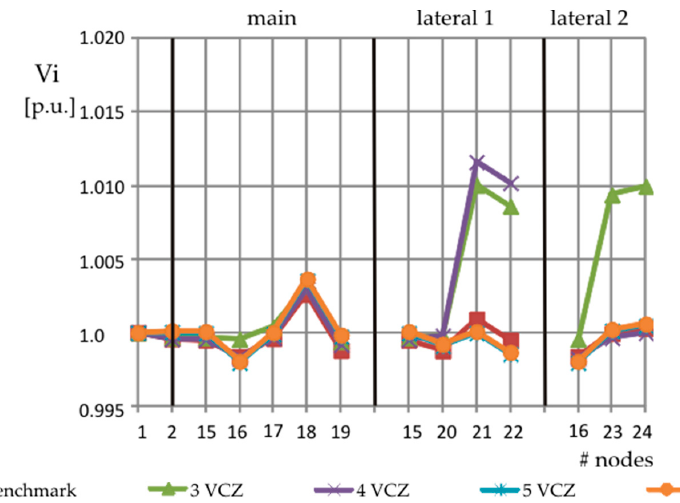
Figure 19 : Voltage profiles for Case X — DG and BESSs: Q algorithm—feeder 2.